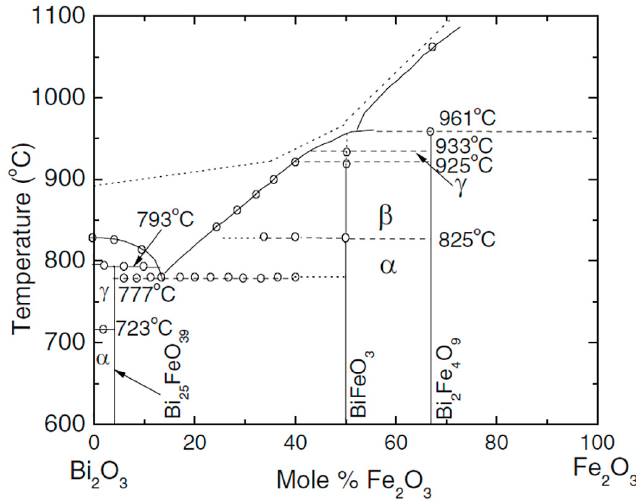
Figure 1. Phase diagram of the Bi 2 O 3 –Fe 2 O 3 system. Open circles show the data points obtained by differential thermal analysis (DTA). The dotted line above the liquidus represents the approximate temperature limit not to be surpassed in order to avoid decomposition, otherwise correct equilibrium DTA peaks are no longer observed upon a second heating. The α , β , and γ phases are rhombohedral, orthorhombic, and cubic, respectively. Adapted from [23], with permission from © 2008 American Physical Society.